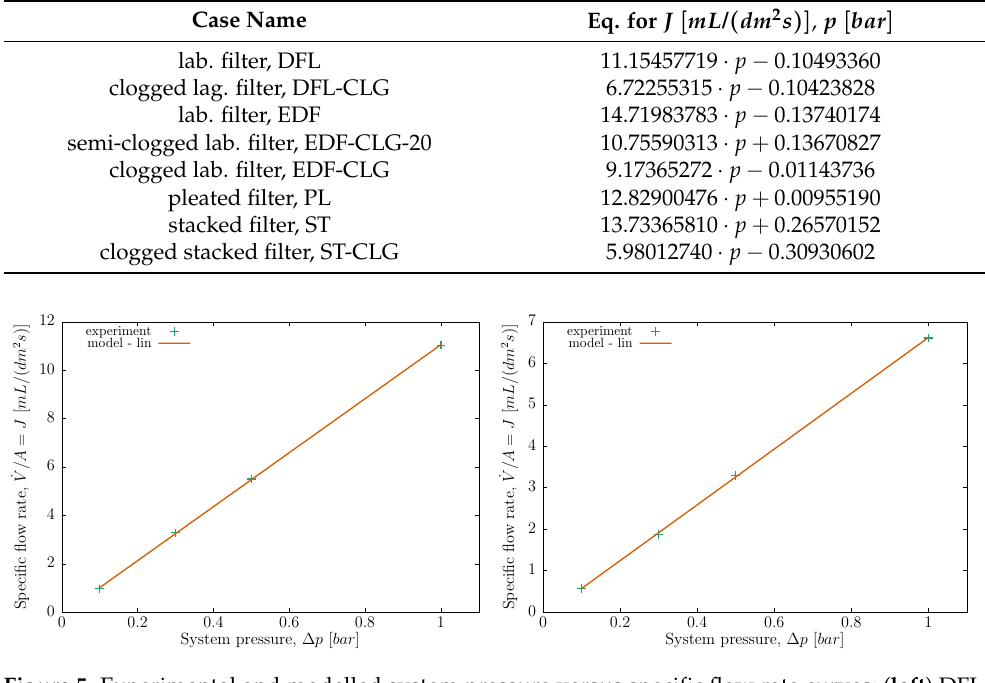
Figure 5. Experimental and modelled system pressure versus specific flow rate curves; ( left ) DFL, ( right )